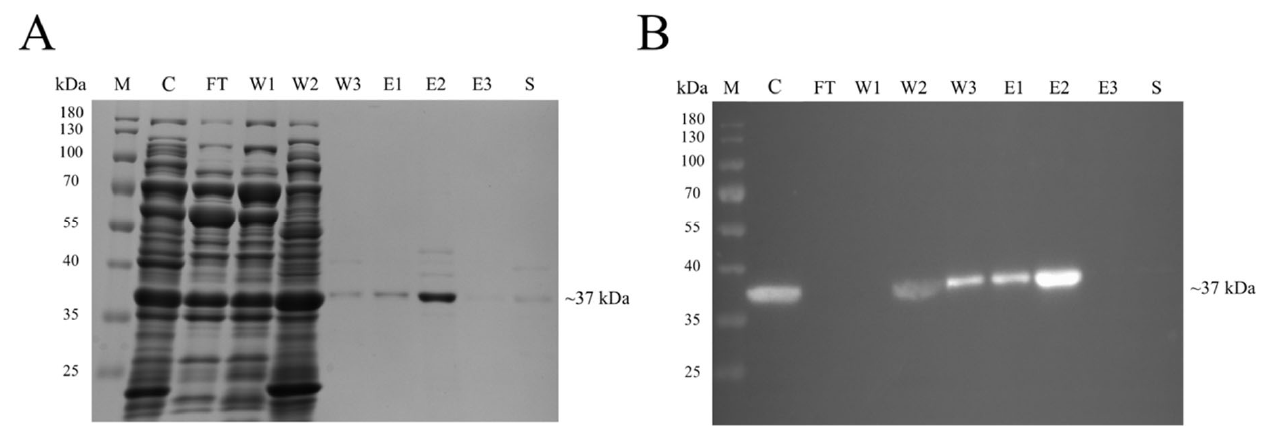
Figure 2. Purification of the recombinant Linked cp Pst DNV-ds pro by affinity chromatography. ( A ) SDS-PAGE and ( B ) western blot analysis of fractions collected from a Zn 2+ saturated HisTrap HP column (Cytiva, Marlborough, MA, USA). The expected band size of Linked cp Pst DNV-ds pro was approximately at 37 kDa. Lane M, PageRuler™ Prestained Protein Ladder (Thermo Fisher Scientific, Waltham, MA, USA); Lane C, crude extract solution; Lane FT, flow thought solution; Lanes W1–W3, proteins eluted by washing buffer; Lanes E1–E3, proteins eluted by elution buffer; Lane S, proteins eluted by stripping buffer.